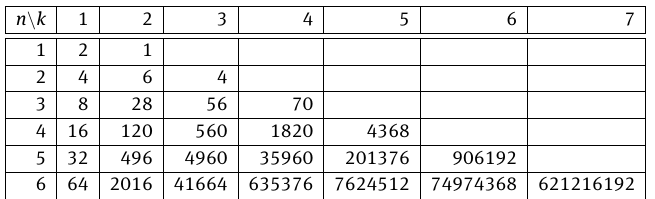
(cid:1) for comparison with Table 2.2. k